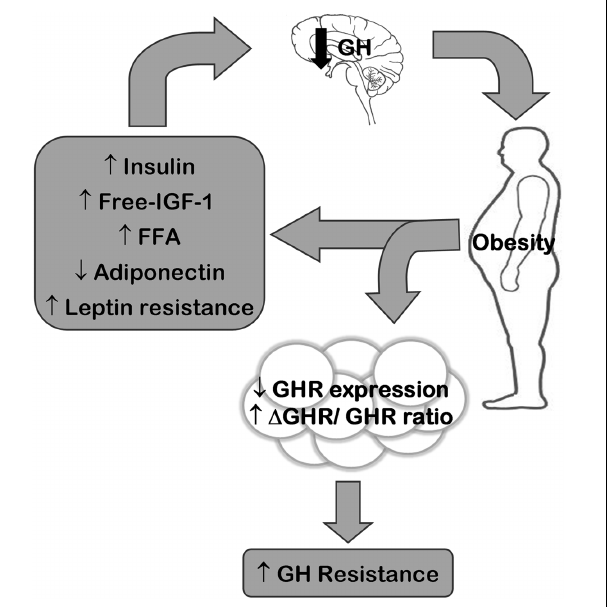
FIGURE 1 | Possible mechanisms mediating reduced GH action in obesity. Obesity-induced hyperinsulinemia, hypoadiponectinemia, leptin resistance, and increased bioactive insulin-like growth factor-1 (IGF-1) and free fatty acid (FFA) levels could suppress GH secretion from the pituitary by various mechanisms (please refer to text). Reduced GH secretion further increases fat accumulation and, thus exacerbates the obesity condition. Moreover, reduced GH receptor (GHR) expression and increased expression of truncated GHR ( Δ GHR) in the adipose tissue results in a GH-resistant state that also contributes to the complications associated with